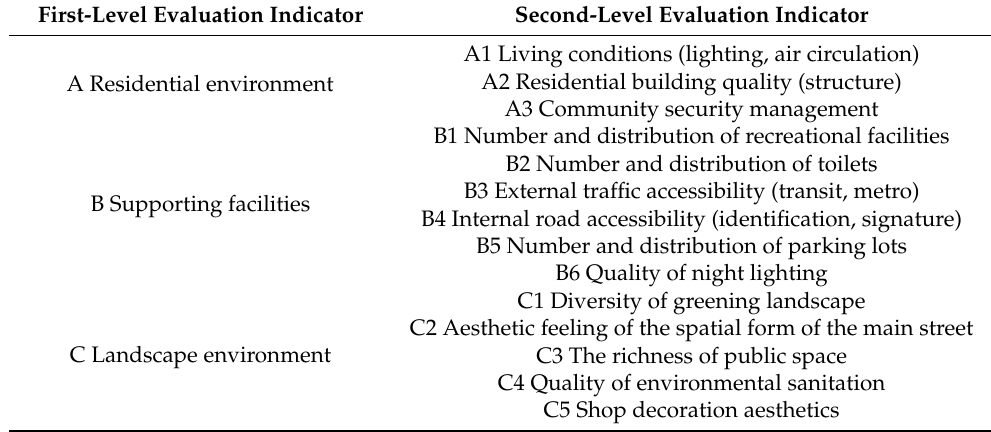
Table 2. The final evaluation index set of the post-renewal evaluation of Nantou Ancient